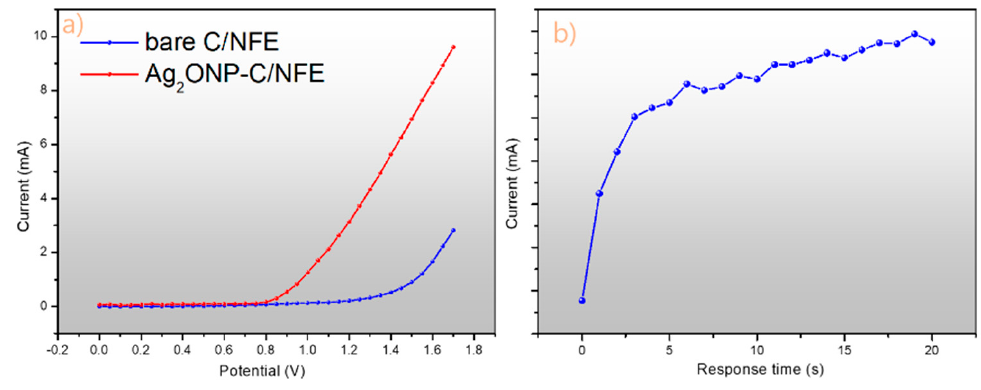
Figure 6. ( a ) I–V response curve of bare carbon black/nickel foam electrode and nickel foam electrode incorporating Ag 2 ONPs and carbon black (Ag 2 ONP–C/NFE) and ( b ) response time (s) at 25 μ L of 0.01 mM p -nitrophenol ( p -NP) added to the phosphate buffer solution pH 6.6 at 25 °C.